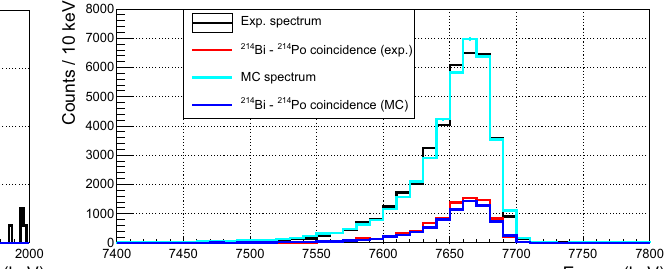
expected, does not match the experimental data at low energies because of contributions from other β -emitters and environmental background. By selecting 214 Bi– 214 Po delayed coincidences in both experimental (red) and MC (blue) data, we get a good reconstruction of both 214 Po α -peak and 214 Bi β